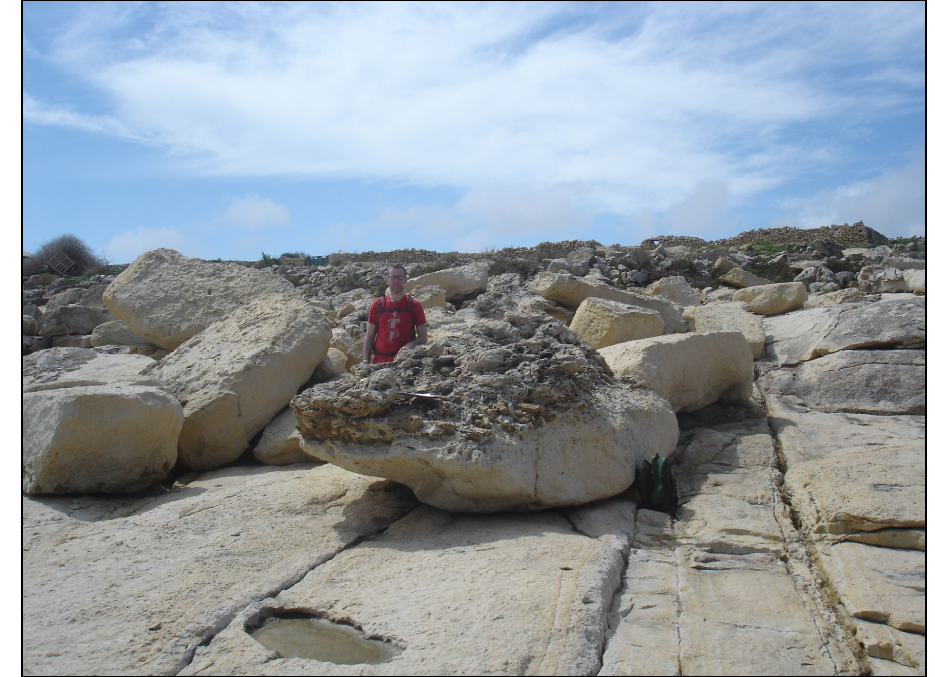
Figure 15. Inverted boulder AM2 that has pivoted over the LGL scarp and then slid up the scarp-top ramp to its current resting place. The boulder reveals on its underside an upturned shelf backed by a mini